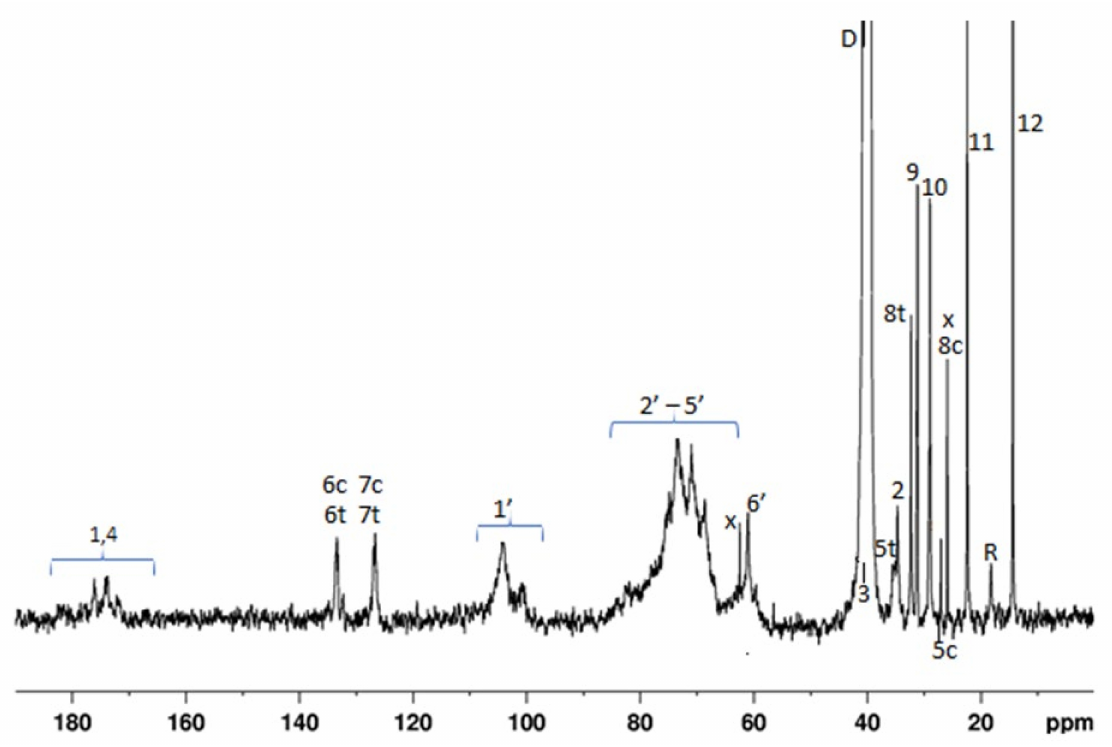
Figure 3. 13 C NMR spectrum of a CG–OSA adduct in d 6 -DMSO. The carbon numbers follow Scheme 1; D = DMSO; R = methyl from rhamnose, x = isopropanol, c = cis, t = trans.